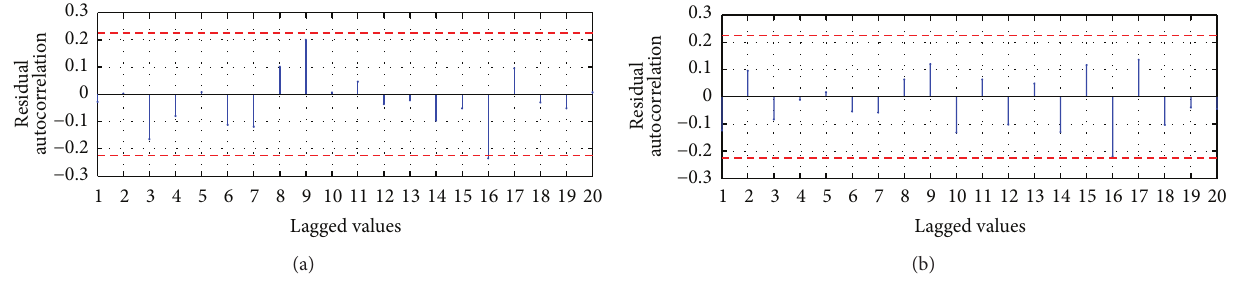
Figure 5: Residual ACF: (a) MA-ARIMA(9,0,10) and (b) SVD-ARIMA(9,0,11).